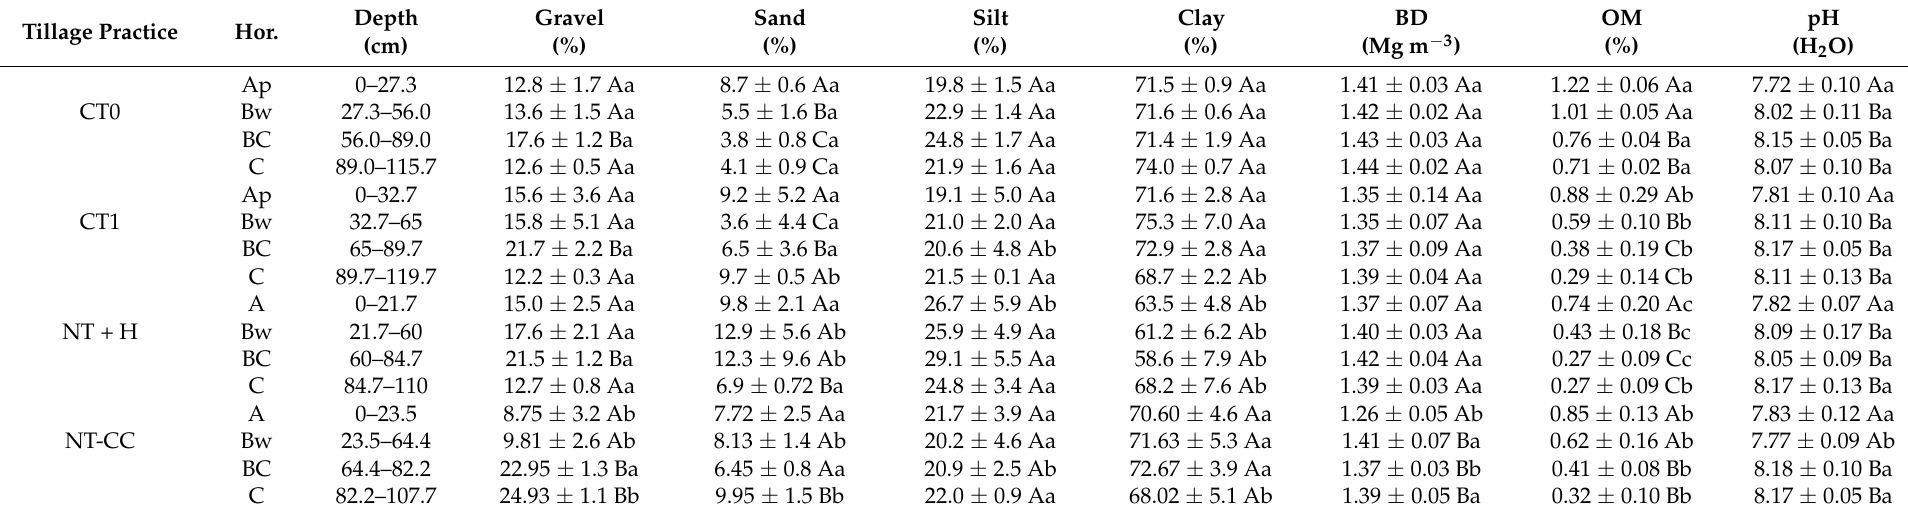
Table 1. Soil physical and chemical properties at the three research plots (average ±